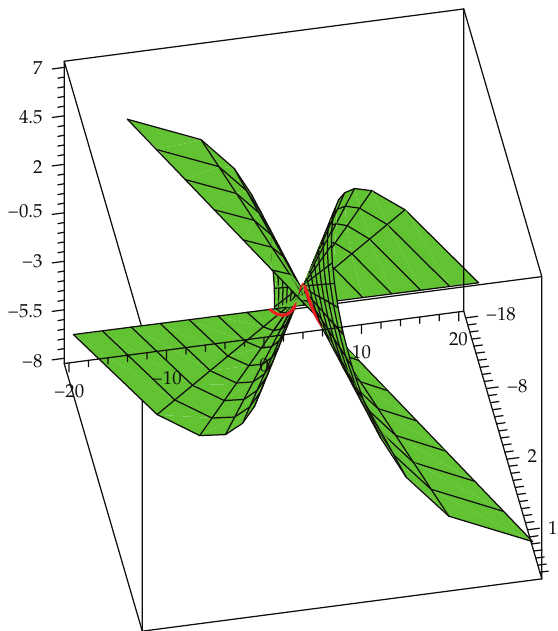
Figure 5: Focal surface and its singulaities.